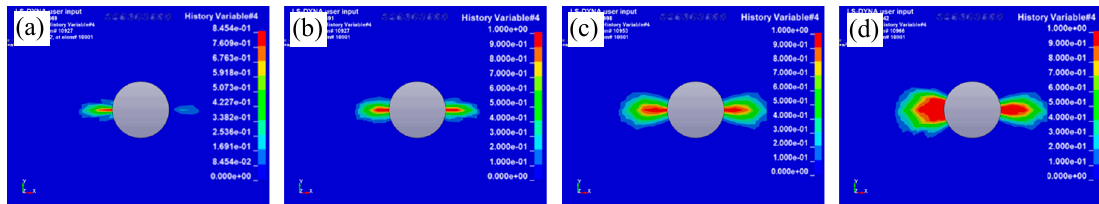
Figure 16. Stress cloud map of cumulative blasting. ( a ) t = 3.922 μ s; ( b ) t = 9.4889 μ s; ( c ) t = 33.998 μ s; ( d ) t = 122.36 μ s.